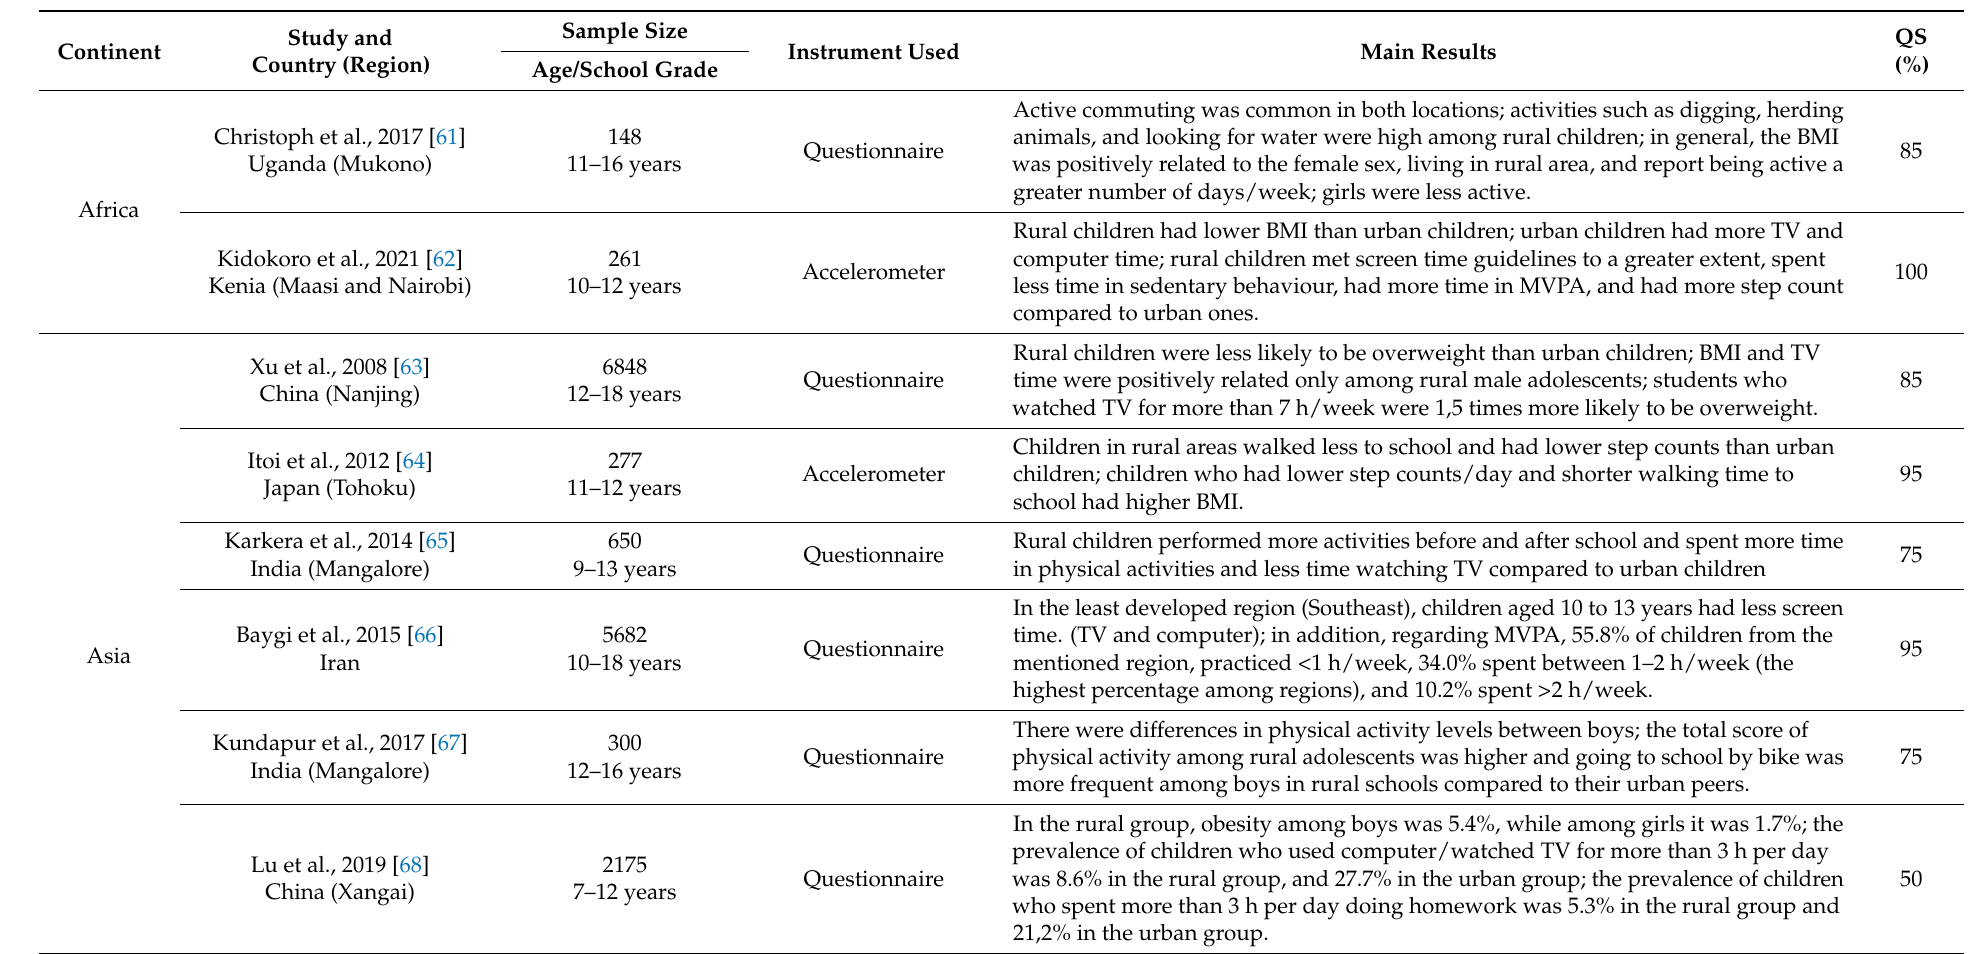
Table 3. Data extracted from articles comparing rural × urban/suburban children